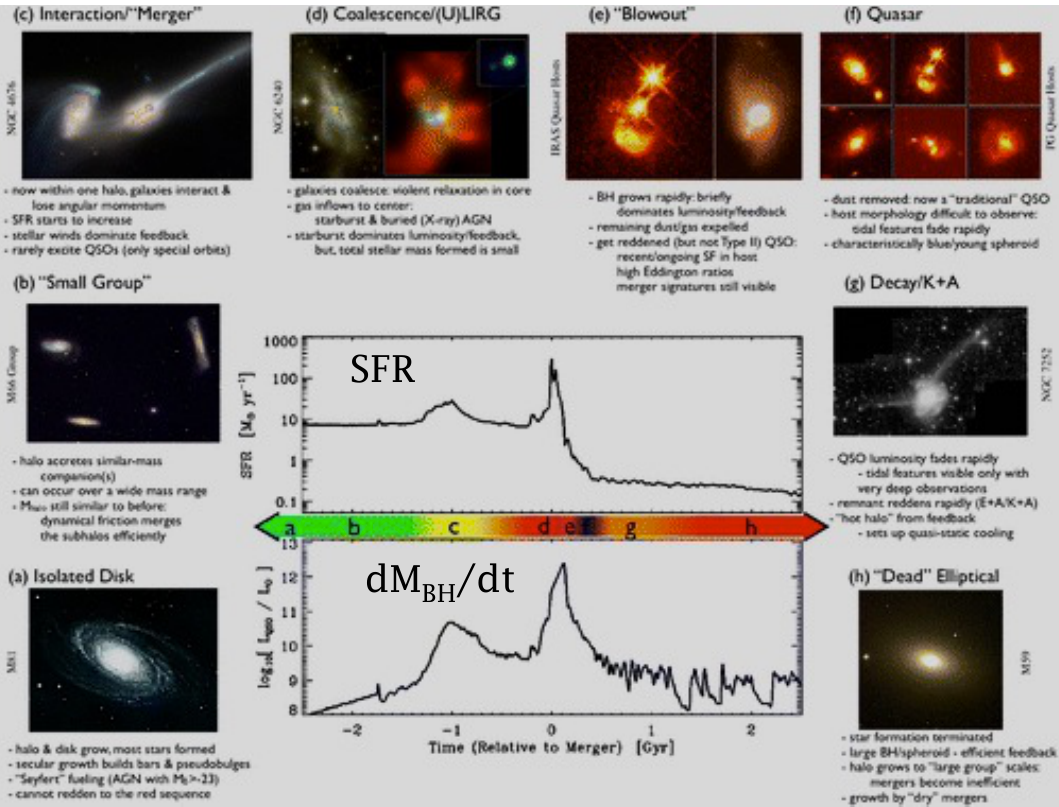
Figure 1: Major-merger scenario. Starting from the merger of two spiral galaxies (left side), the merger produces a violent SB and the onset of QSO activity (middle) and ends with the formation of a dead spheroid (right side). From Hopkins et al.